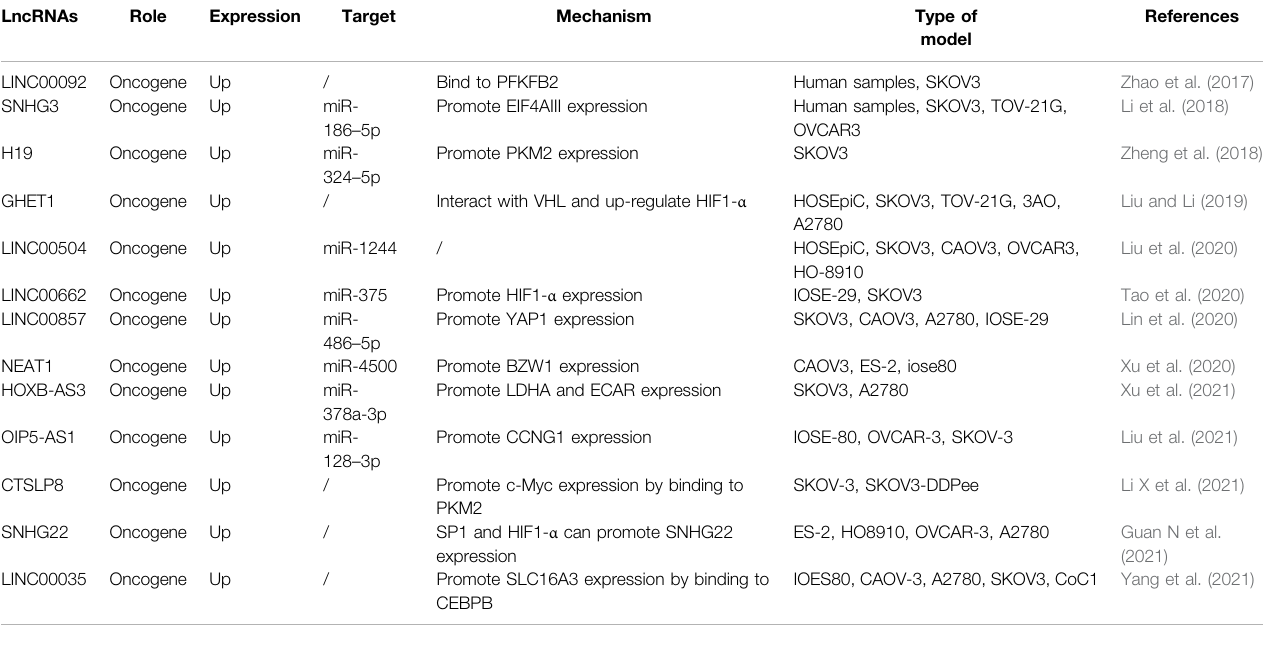
TABLE 2 | lncRNAs involved in glycolysis in ovarian cancer.